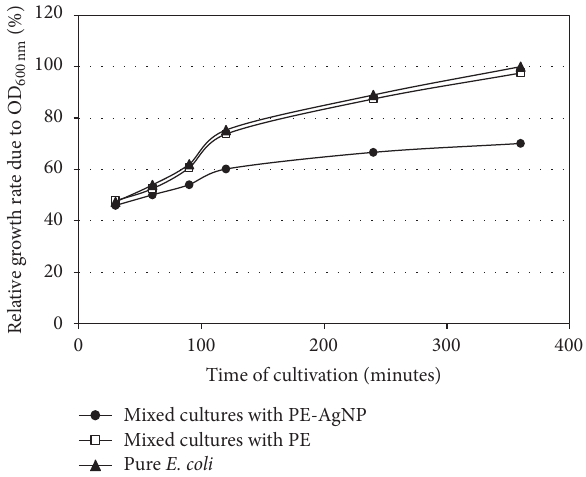
Figure 9: Influence of the PE-AgNP nanocomposites on the growth rate of the E. coli liquid cultures. The data points represent the means of three cultures (standard deviation < 10%).